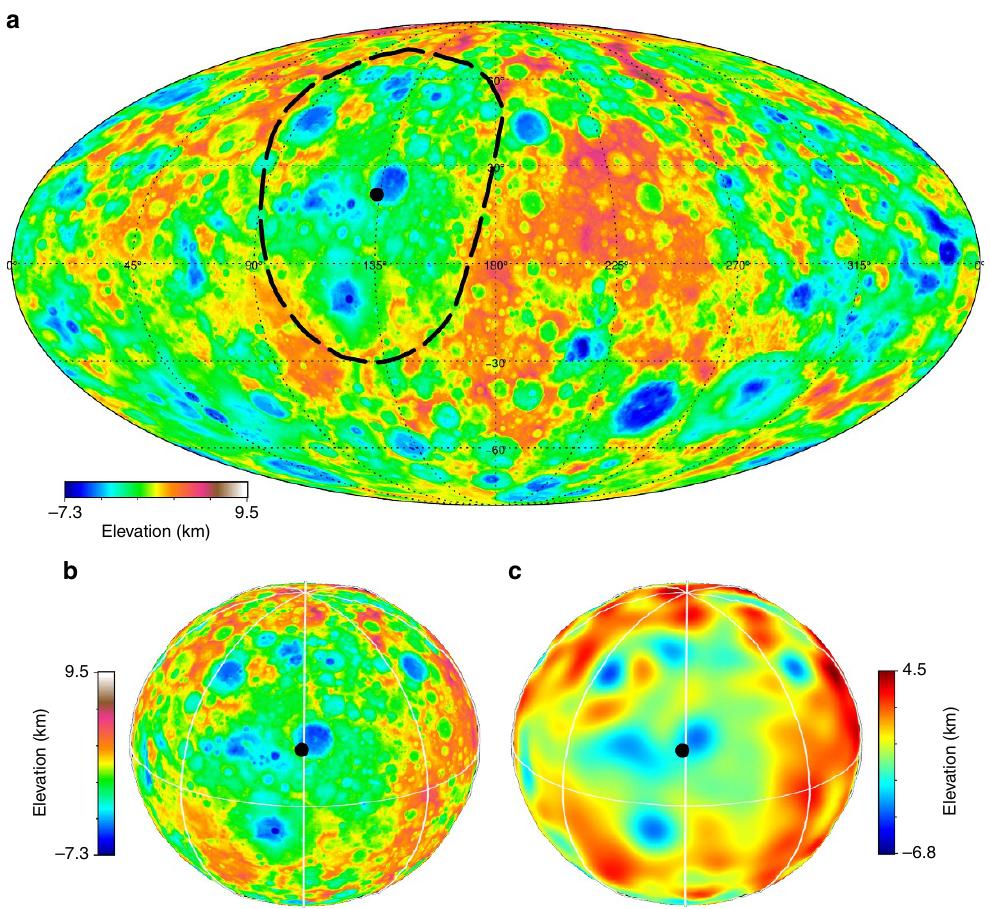
Figure 3 | Ceres’ Vendimia Planitia. ( a ) Mollweide projection of Ceres’ topography. Dashed black line indicates a major depression or planitia. Black dots indicate the approximate centre of the depression. ( b , c ) 3D views of Vendimia Planitia in real and filtered topography, respectively. White lines indicate 45 (cid:2) -spaced meridians and the equator. Topography range is (cid:2) 7.3 to þ 9.5km, while filtered topographic range is (cid:2) 6.8 to þ 4.5km. The latter has been derived by applying a cosine taper to shape spherical harmonic coefficients between degree 15—corresponding to a scale of 200km—and degree